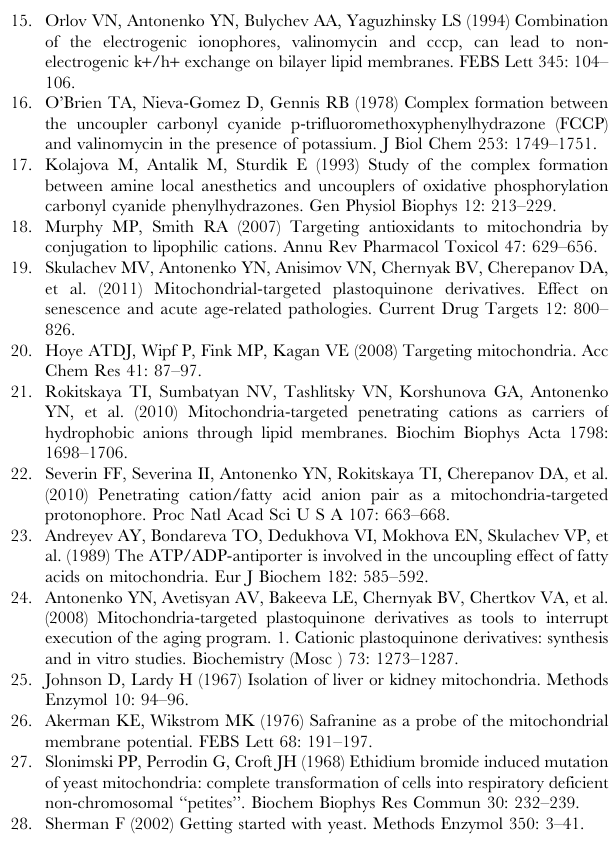
Figure S2 C 12 TPP did not affect the ability of neither FCCP (A) nor DNP (B) to decrease optical density of yeast respiratory-incompetent cells grown up to